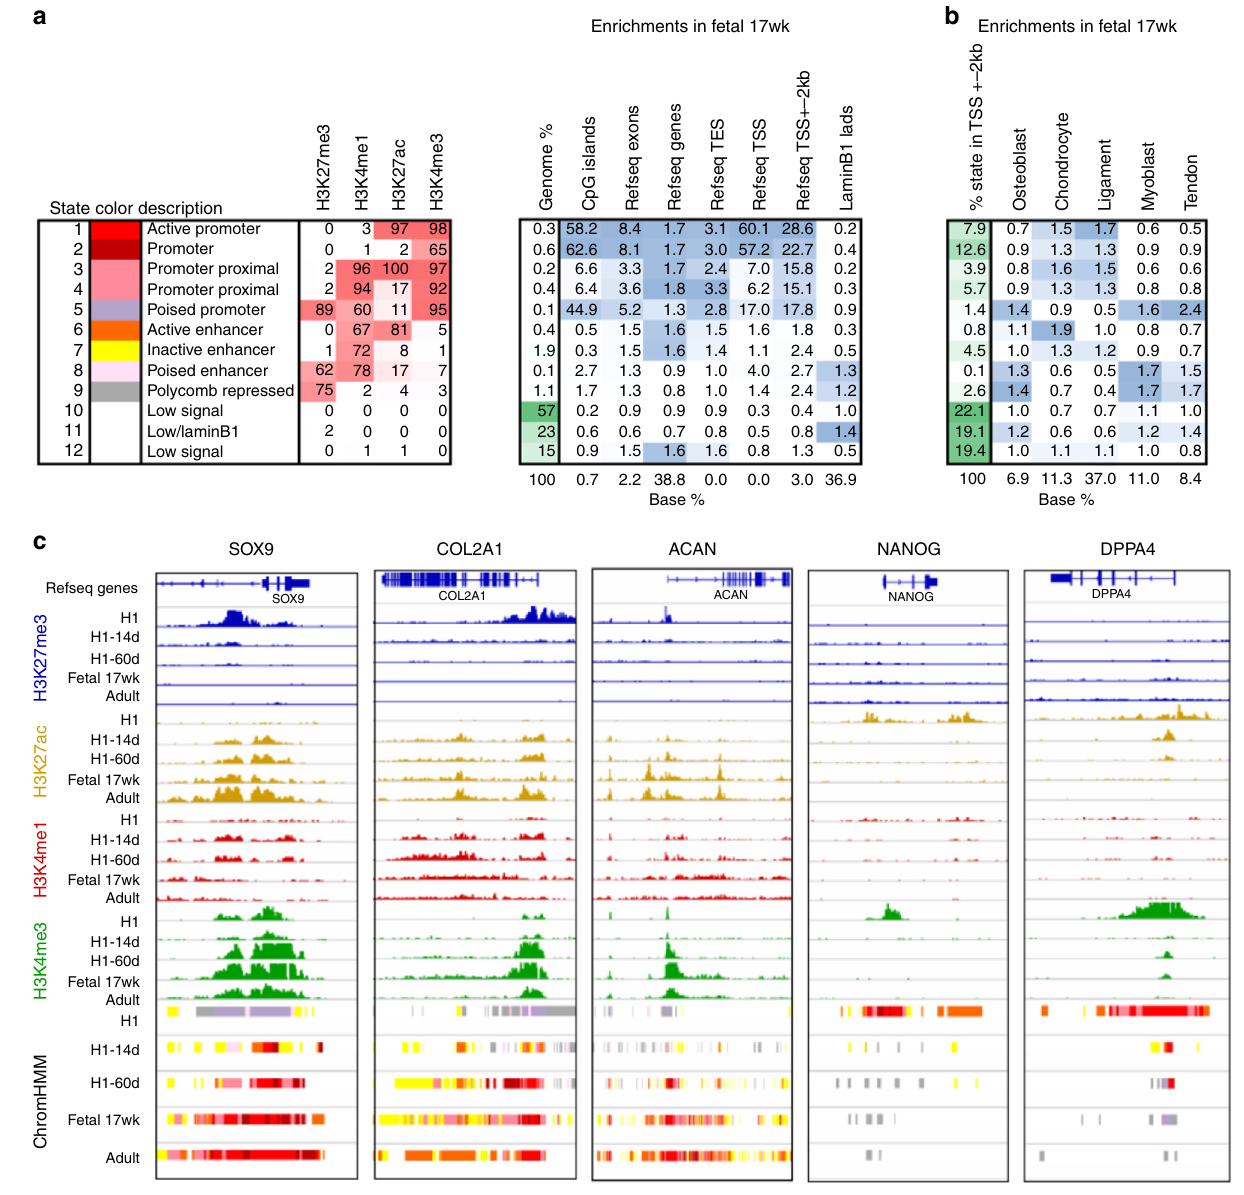
Fig. 6 Human fetal chondrocyte identity is regulated at the epigenetic level. a Left panel: Chromatin state de fi nitions (emission probabilities) for the 12 state ChromHMM model. Rows correspond to chromatin states. Columns correspond to chromatin state number, color code, candidate description and histone marks. Numbers in the histone mark columns show the frequency of occurrence of each mark in each chromatin state on the scale from 0 (white) to 100 (red). Right panel: Enrichment scores for chromatin states in genomic features. The fi rst column shows the genome-wide percentage of occupancy for each state on the scale from 0 (white) to 100 (green). Subsequent columns show enrichments for CpG islands, Refseq annotated exons, genes, transcription ends sites (TES), transcription start sites (TSS), TSS + − 2 kb regions and laminB1 domains. Each column is colored from 0 (white) to its maximum value (blue). The bottom row shows the baseline percentage of genomic territory occupied by each feature. b Enrichments of chromatin states from Fetal 17-weeks in TSS proximal regions (de fi ned as TSS + − 2 kb) of genes from different gene expression modules identi fi ed by WGCNA. The fi rst column shows the baseline percentage occupied by each chromatin state in all annotated TSS + − 2 kb regions on the scale from 0 (white) to 100 (green). Subsequent columns show the enrichments for each state in each expression module based on the fraction occupied by that state in the TSS proximal regions of all genes. Each column is colored from 0 (white) to its maximum value (blue). The bottom row shows the baseline fraction of each module out of all genes. Promoters of cartilage and ligament genes are enriched for active promoter states, whereas bone, muscle and tendon genes are enriching for Polycomb-repressed, poised and low signal states. c Chromatin data from all four cell types interrogated in this study and from H1-hESC at speci fi c genes involved in either cartilage development (SOX9, COL2 and ACAN) or pluripotency (NANOG and DPPA4). ChromHMM tracks are colored according to the color codes in a . N = 3 –